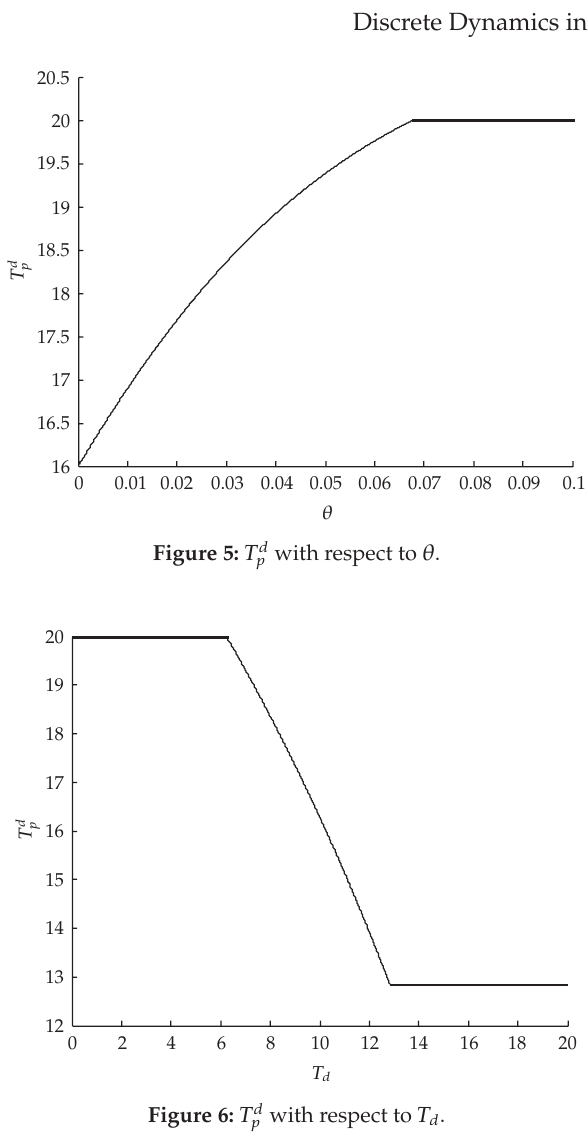
with respect to T d p